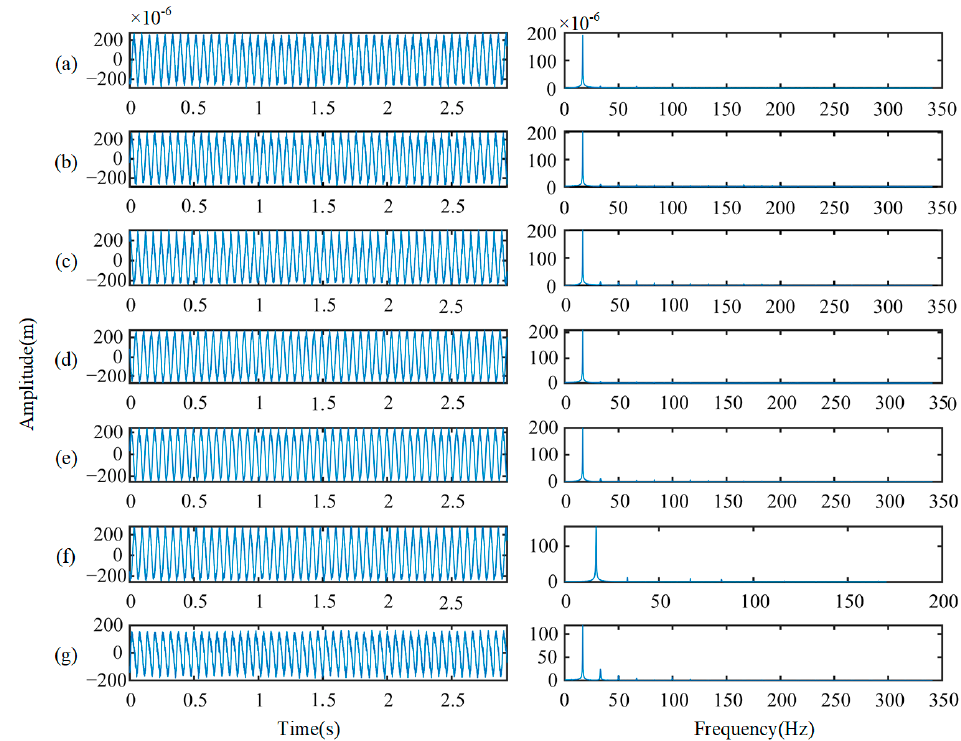
Figure 9. Original displacement signals and spectral distributions: ( a ) health; ( b ) full annular rub; ( c ) blade crack and bearing fault; ( d ) blade crack; ( e ) blisk crack; ( f ) shaft coupling fault; ( g ) shaft crack.